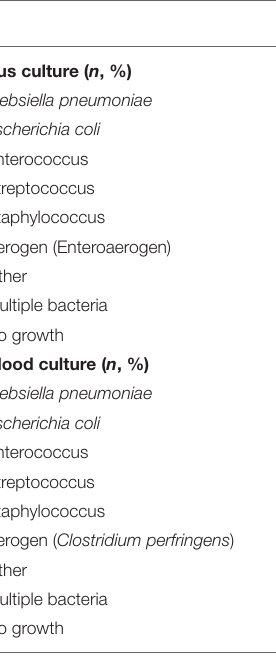
TABLE 3 | Microbiological